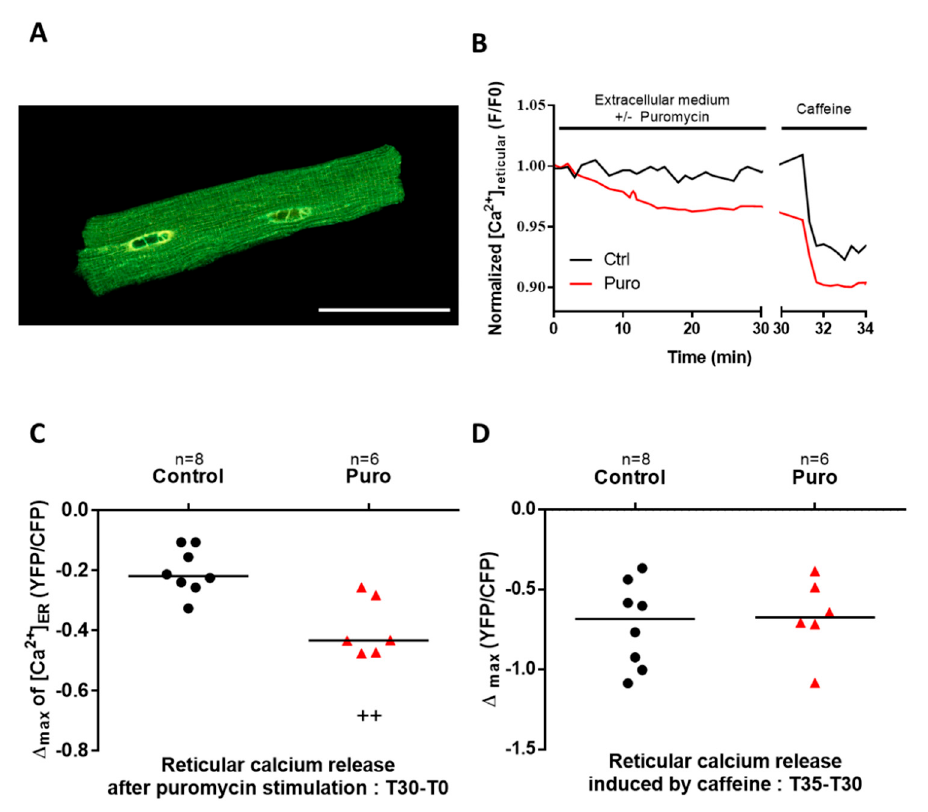
Figure 1. Translocon (TLC) activation by puromycin induces a decrease in reticular Ca 2+ stock. ( A ) Illustration of the in vivo adenoviral strategy to express a reticular Ca 2+ sensor, D4ER, in adult mouse cardiomyocytes, presenting a typical reticular pattern of the fluorescent sensor as displayed on the representative confocal image. Scale bar: 50 μ m. ( B ) Graphical representation of the D4ER fluorescence ratio evolution with time in control condition (black line) and in response to 30 min of 200 μ M puromycin treatment (red line), both stimulated with 5 mM caffeine; representative curve of reticular fluorescence evolution in control (Ctrl) condition and under puromycin treatment. ( C ) Scatter plots of reticular Ca 2+ decreased at the end of 30 min perfusion with or without puromycin. ( D ) Scatter plots of the ryanodine receptor (RyR)-dependent reticular Ca 2+ stock after puromycin or Ctrl treatment estimated by caffeine stimulation, calculated as difference between fluorescence level at stimulation time and final fluorescence. n = cell count. Statistics: ++ p < 0.01 vs. Ctrl.